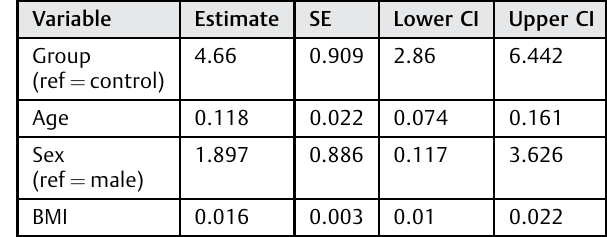
Table 1 Bayesian path analysis output to investigate the effect of intervention, age, gender, and BMI on anesthesia duration Variable